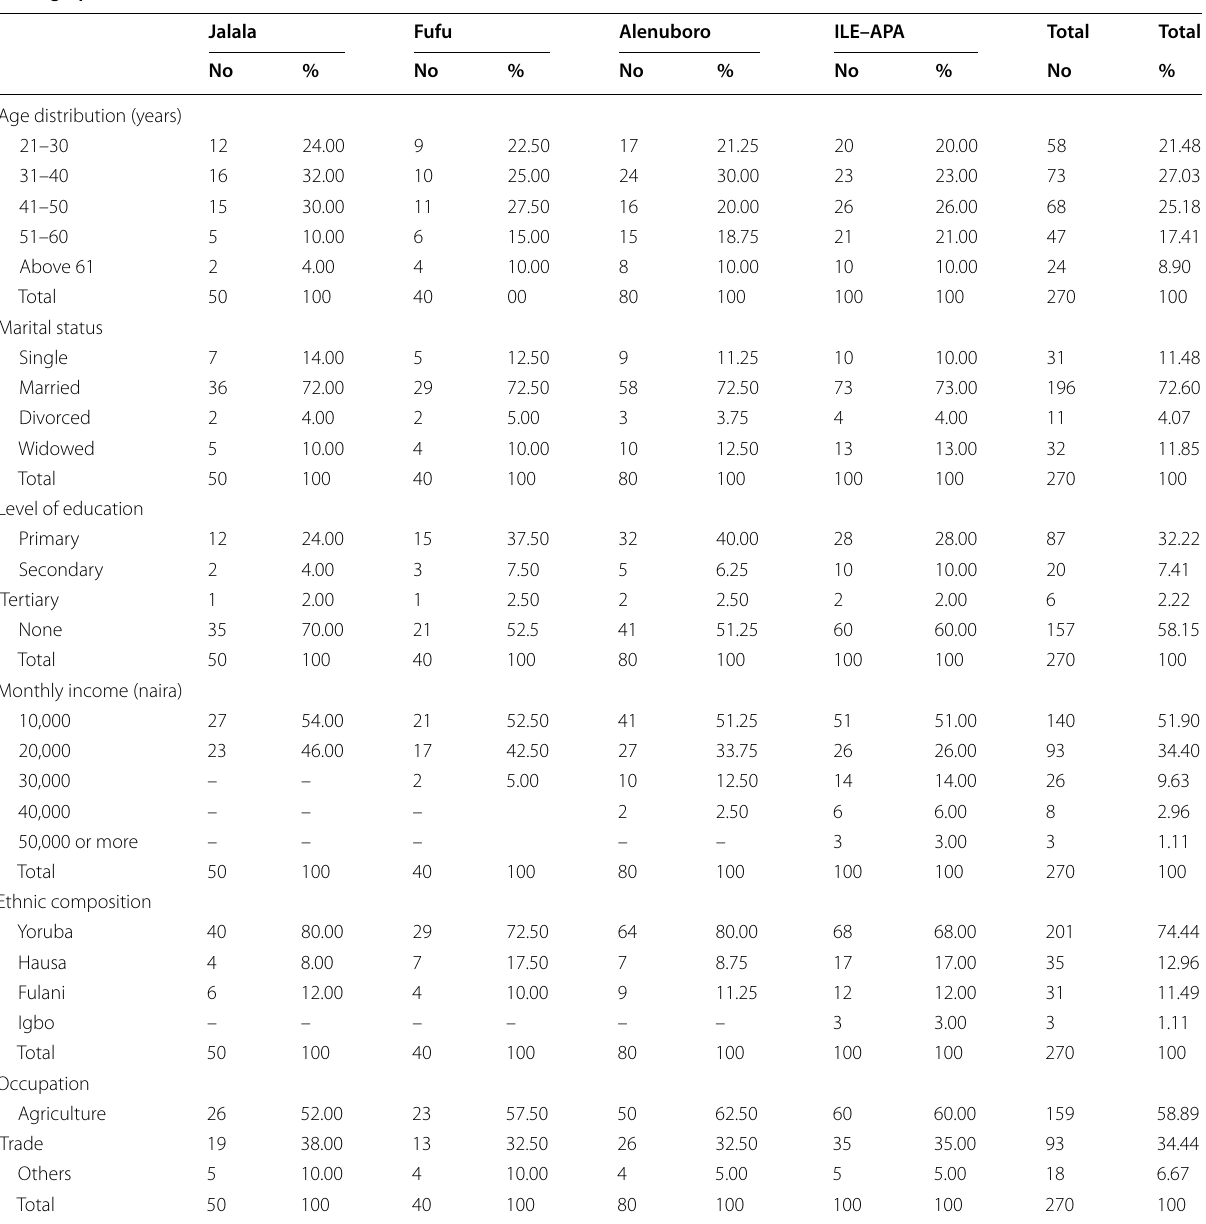
Table 1 Demographic characteristics of the respondents Demographic